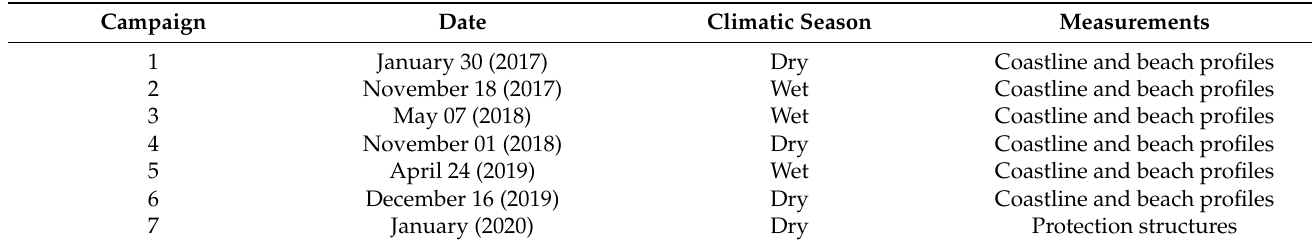
Table 1. Dates of the campaigns and climatic season respectively.